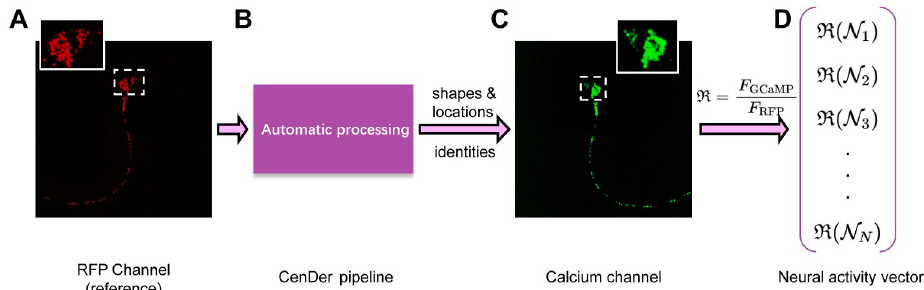
Fig 7. The CeNDeR system. (A) An RFP channel volume. (B) The CeNDeR pipeline takes the raw imaging data and outputs the location, shape and identity of every neuron in a volume. (C) A calibrated linear map allows the identification of each neuron’s location in the green channel, from which the calcium fluorescence signals, F GCaMP of all recognized neurons can be extracted. (D) The whole-brain neural activity vector R can be inferred from the ratio of F GCaMP to F RFP